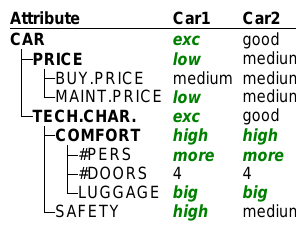
Figure 4. Example evaluation of two cars.